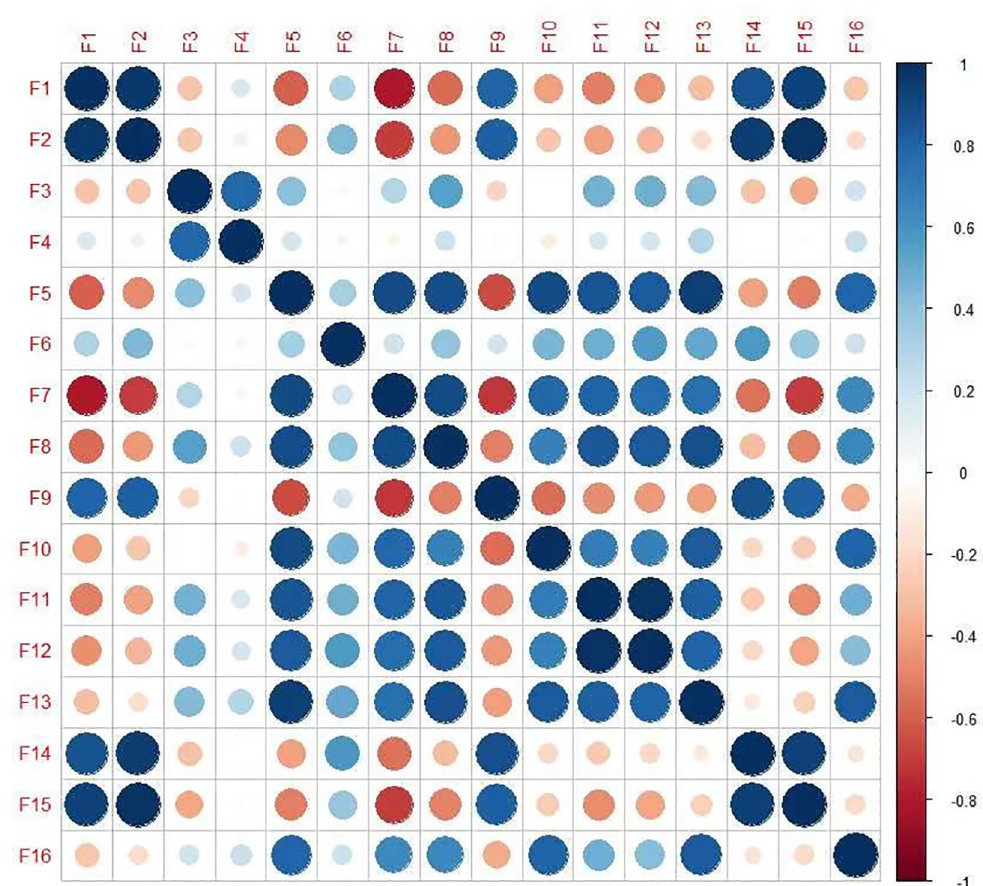
Fig 5. Correlation among variables of mutton industry competitiveness. Note : F1: Number of Raised Sheep, F2: Mutton Production, F3: Animal Husbandry Technical Institutions, F4: Animal Husbandry Technician, F5: Total Population, F6: Consumption Level of Residents, F7: Number of Tourists, F8: Tourism Income, F9: Sheep Stud Farm, F10: Large-Scale Sheep Farm, F11: Corporate Enterprise of Catering Trade, F12: Number of Employees in Catering Enterprises, F13: Output Value of Animal Husbandry, F14: Mutton Brands Favored by Consumers, F15: Large-Scale Sheep Farm with More than 500 Annual Column Quantities, F16: Fixed Assets Investment in Agriculture, Forestry, Animal Husbandry and Fishery.